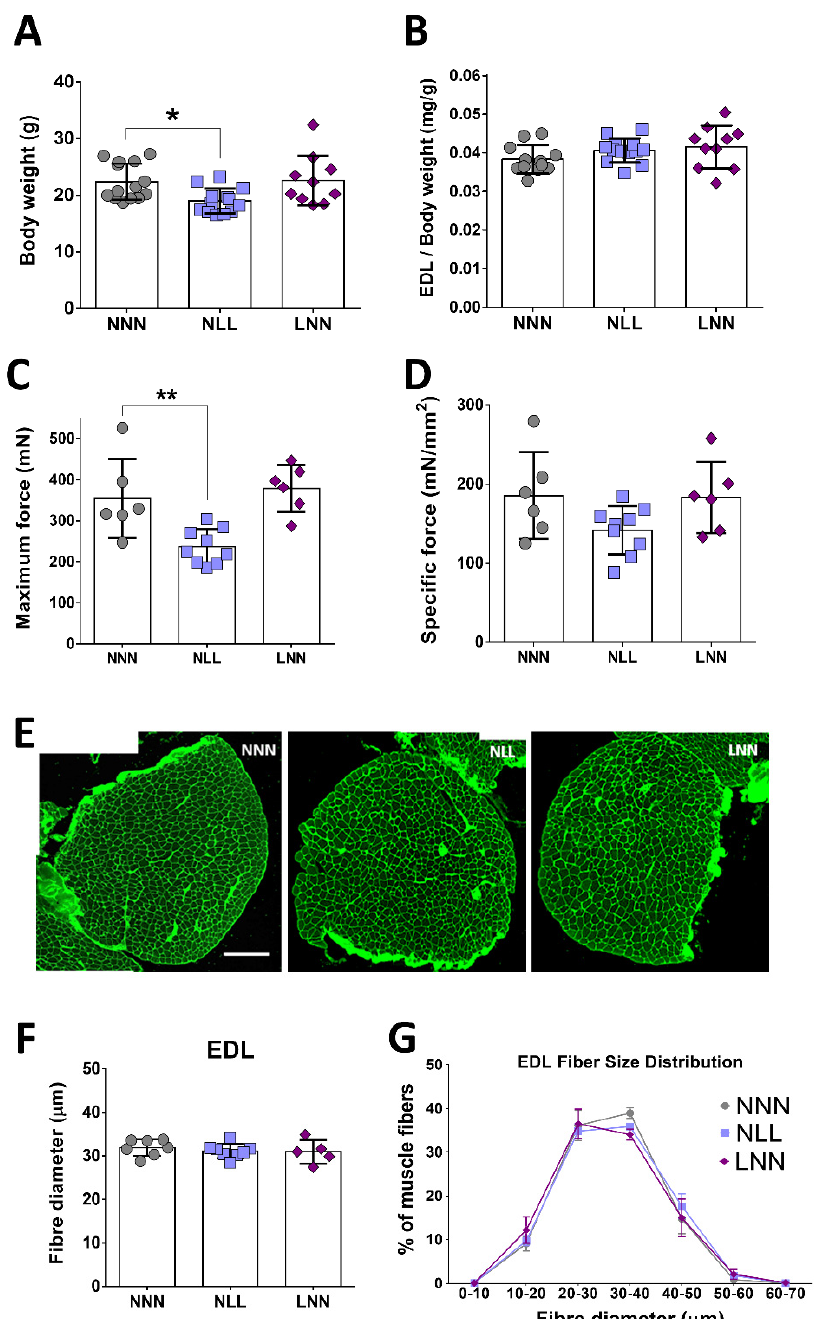
Figure 2. The effects of reduced protein intake in utero or postnatally on the body and muscle weight as well as EDL muscle forces of 12–week–old mice. NLL mice showed reduced total body weight ( A ), but no difference was observed when absolute muscle weights of EDL were adjusted to total body weights ( B ). Maximum force showed a reduction in the NLL group of mice ( C ), while analysis of the specific tetanic force revealed no differences ( D ). Representative images of histological examination of the EDL muscle of 12-week-old mice are shown ( E ). EDL fibre size, expressed as Ferret’s diameter, showed no differences between groups ( F ). Myofibre size distribution analysis of EDL muscle, expressed as a percentage of total muscle fibres analysed in EDL muscle of 12-week-old mice, revealed no changes between groups ( G ). NNN was used as the control group for all statistical comparisons. Scale bars = 200 µ m, * p ≤ 0.05 and ** p ≤ 0.01 (mean ± SD; n =